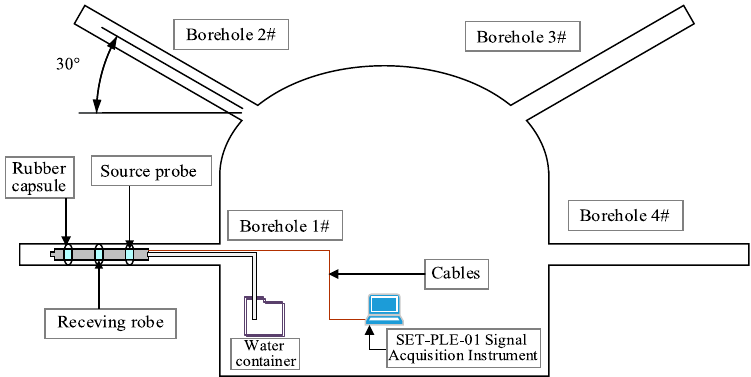
Figure 3. The arrangement of monitored boreholes around roadways.